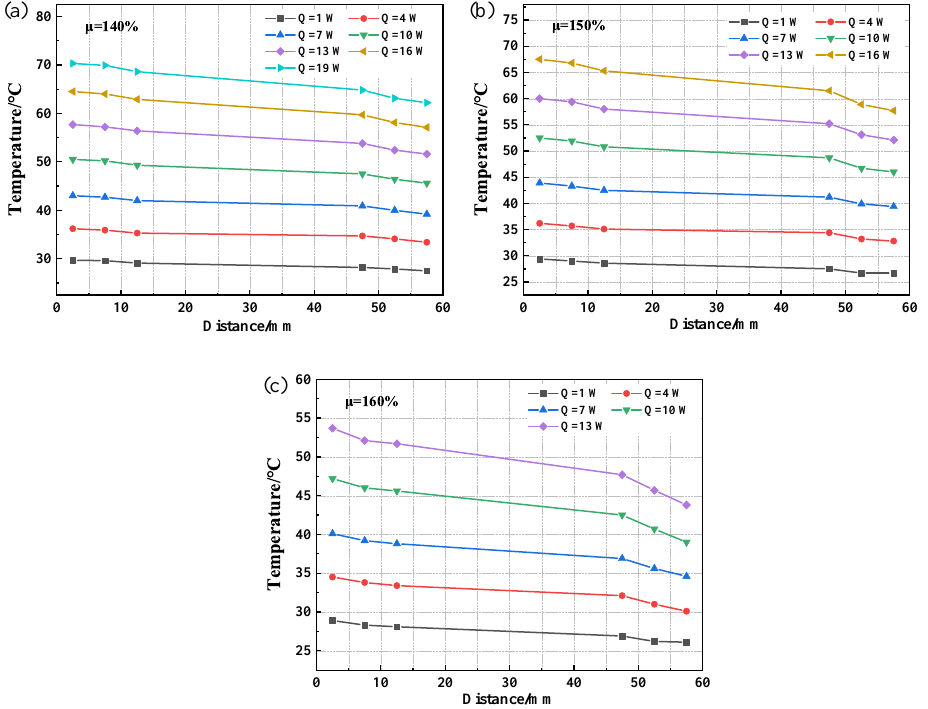
Figure 12. Axial temperature distribution of OCW-FMHP under different thermal power. ( a ) 140% filling rate; ( b ) 150% filling rate; ( c ) 160% filling